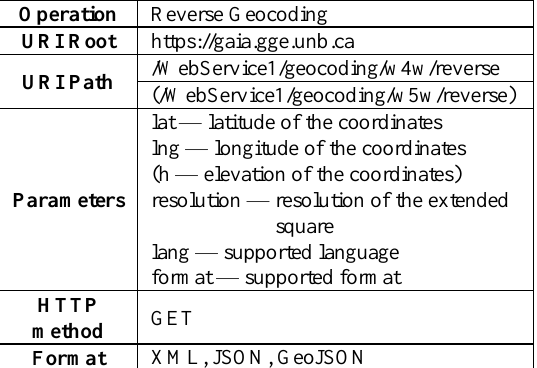
Table 4. Extended w3w reverse geocoding API reference